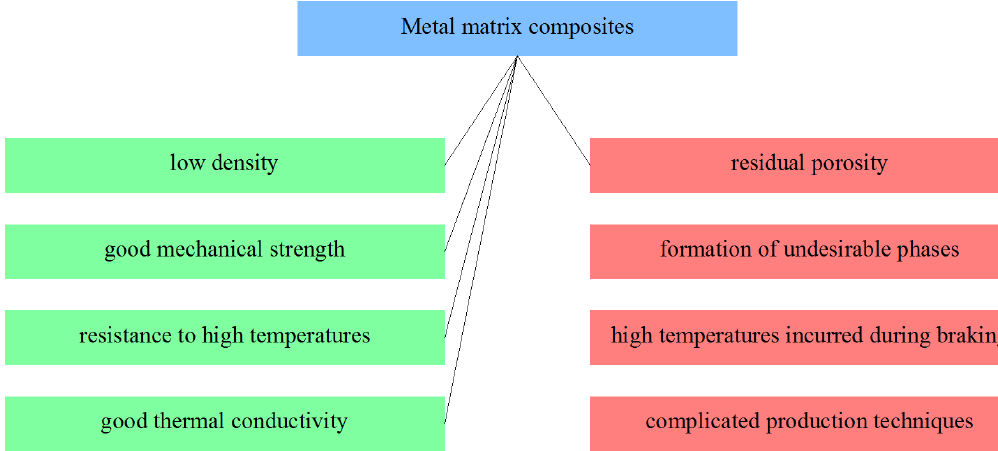
Figure 10: Selected MMC properties from the point of view of applicability in friction